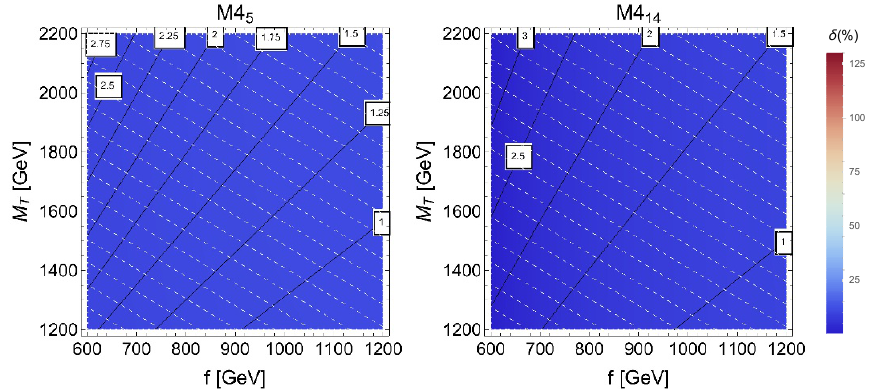
Figure 12 . The contour plots of (cid:14) with sin 2 (cid:18) R = 0 : 4 and p cut models with one top partner multiplet. The corresponding values of y are indicated by the solid lines. As indicated by the dashed white lines, all points on these plots result in (cid:20) t (cid:20) 0 : 8.